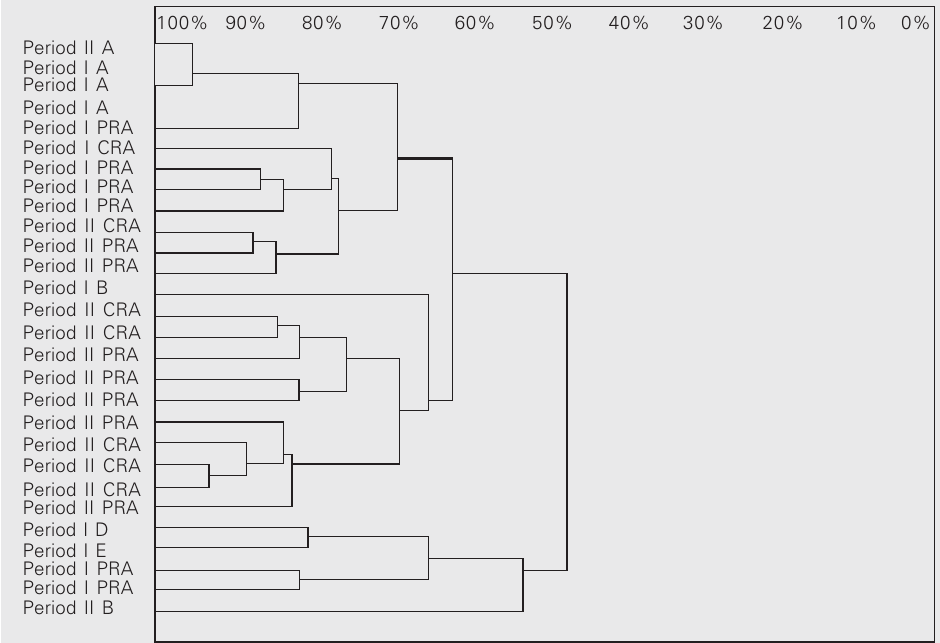
Figure 3. Dendrogram of the methicillin-resistant Staphylo- coccus aureus (MRSA) strains detected by pulsed-field gel electrophoresis during periods I and II, and profiles A, B, D, and E. The values were gener- ated from the Dice coefficient showing the similarity of MRSA strains isolated from April 1991 to February 1993 (period I) and from May 1995 to August 2001 (period II). CRA = closely re- lated to profile A; PRA = possi- bly related to profile